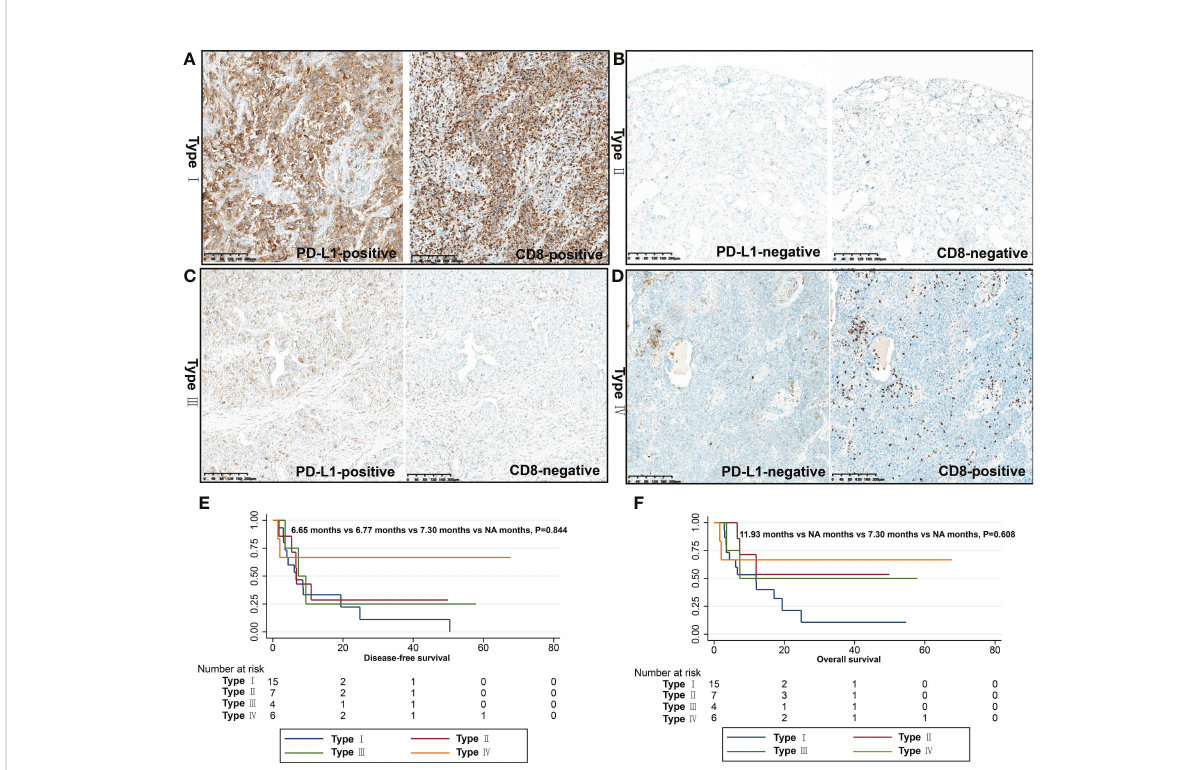
FIGURE 6 Immunophenotyping based on CD8+ T cell in fi ltration and PD-L1 expression. (A) Type I (PD-L1+/CD8+, adaptive immune resistance); (B) Type II (PD-L1-/CD8-, immunologic ignorance); (C) Type III (PD-L1+/CD8-, intrinsic induction); (D) Type IV (PD-L1-/CD8+, tolerance); DFS (E) and OS (F) of different immunophenotypes.